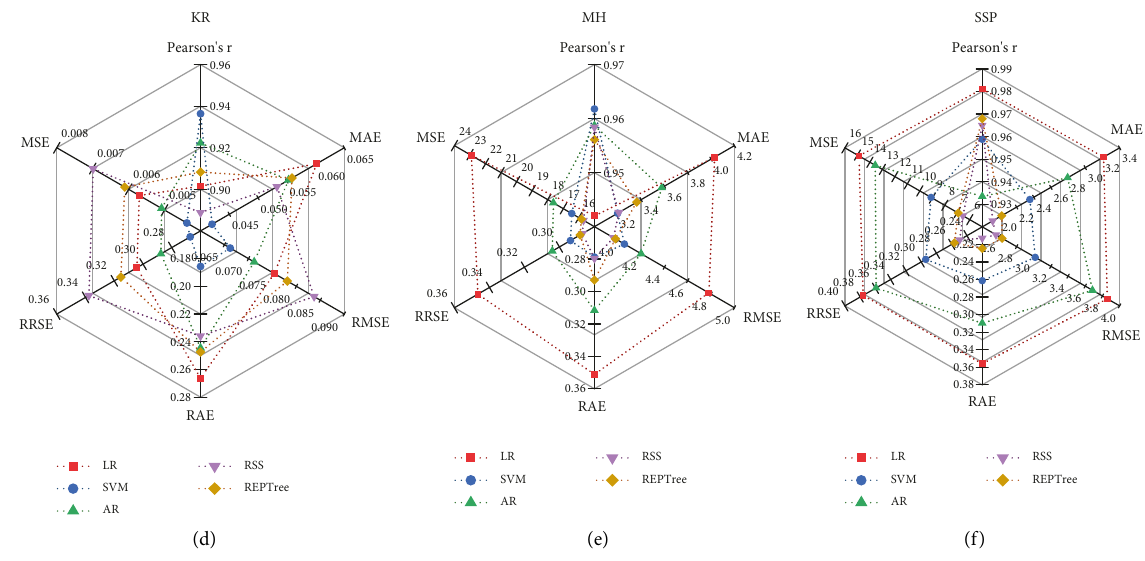
Figure 6: Indicators for all six irrigation indices are shown in a radar graphic